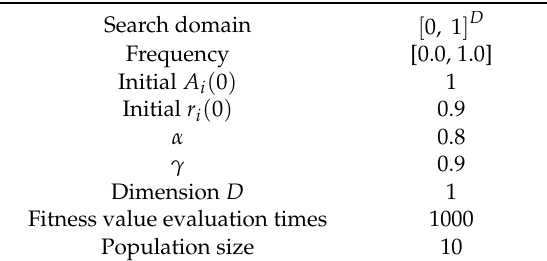
Table 2. Parameter settings for bat algorithm.